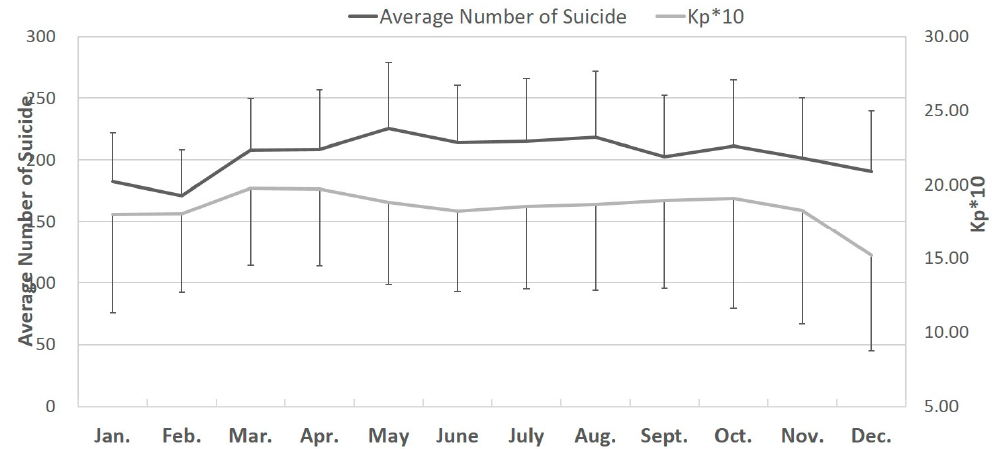
Figure 2. Changes in the monthly number of female suicide attempts and monthly Kp10 values from January 1997 to December 2013.